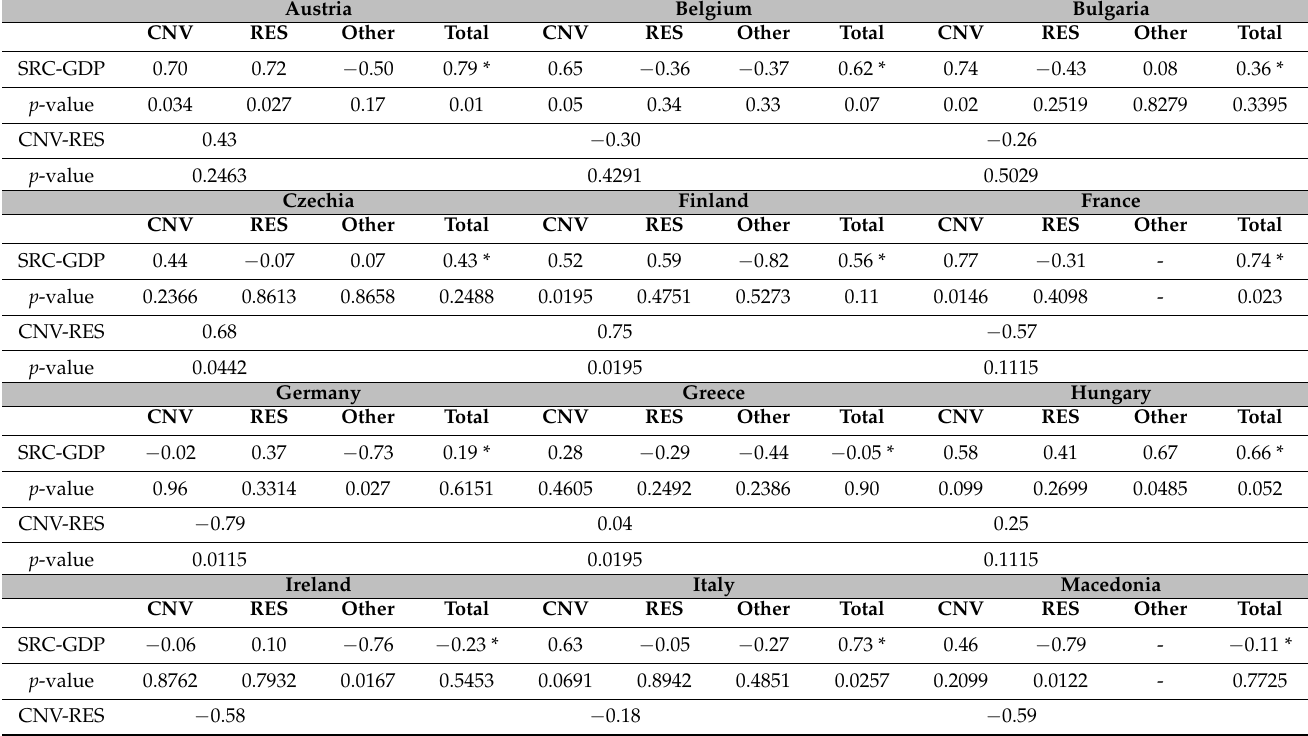
Table 3. The results of the research. Source: own calculations on the basis of